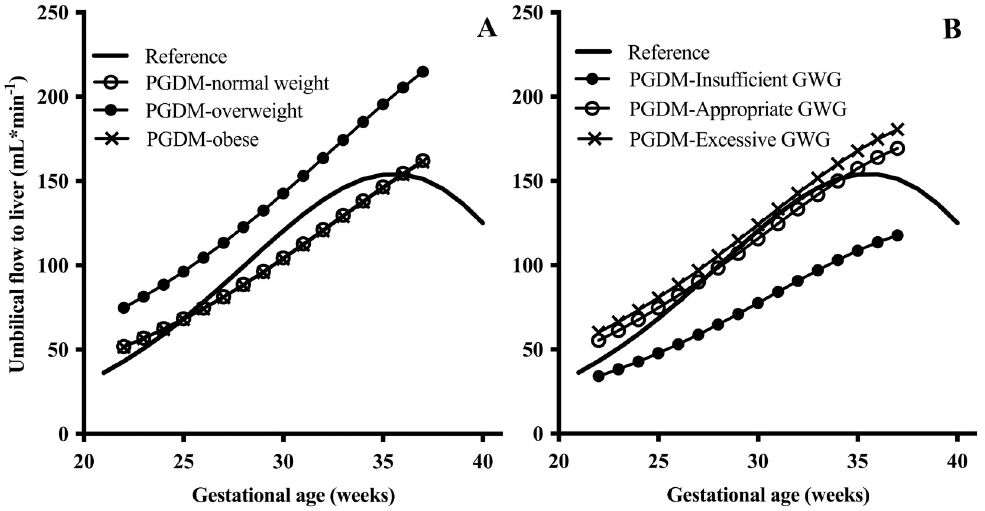
Fig 4. Development of umbilical flow to the fetal liver and its association with BMI or gestational weight gain in pregnancies with pregestational diabetes mellitus (n = 49) compared with that of the reference pregnancies (n = 160).